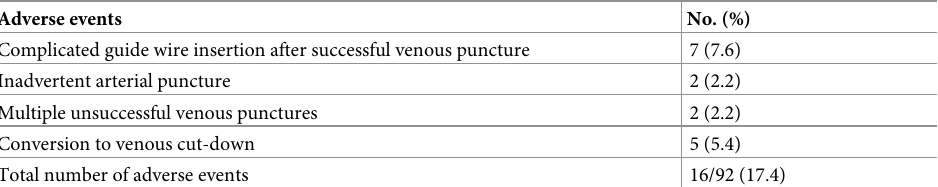
Table 2. Adverse events during catheter